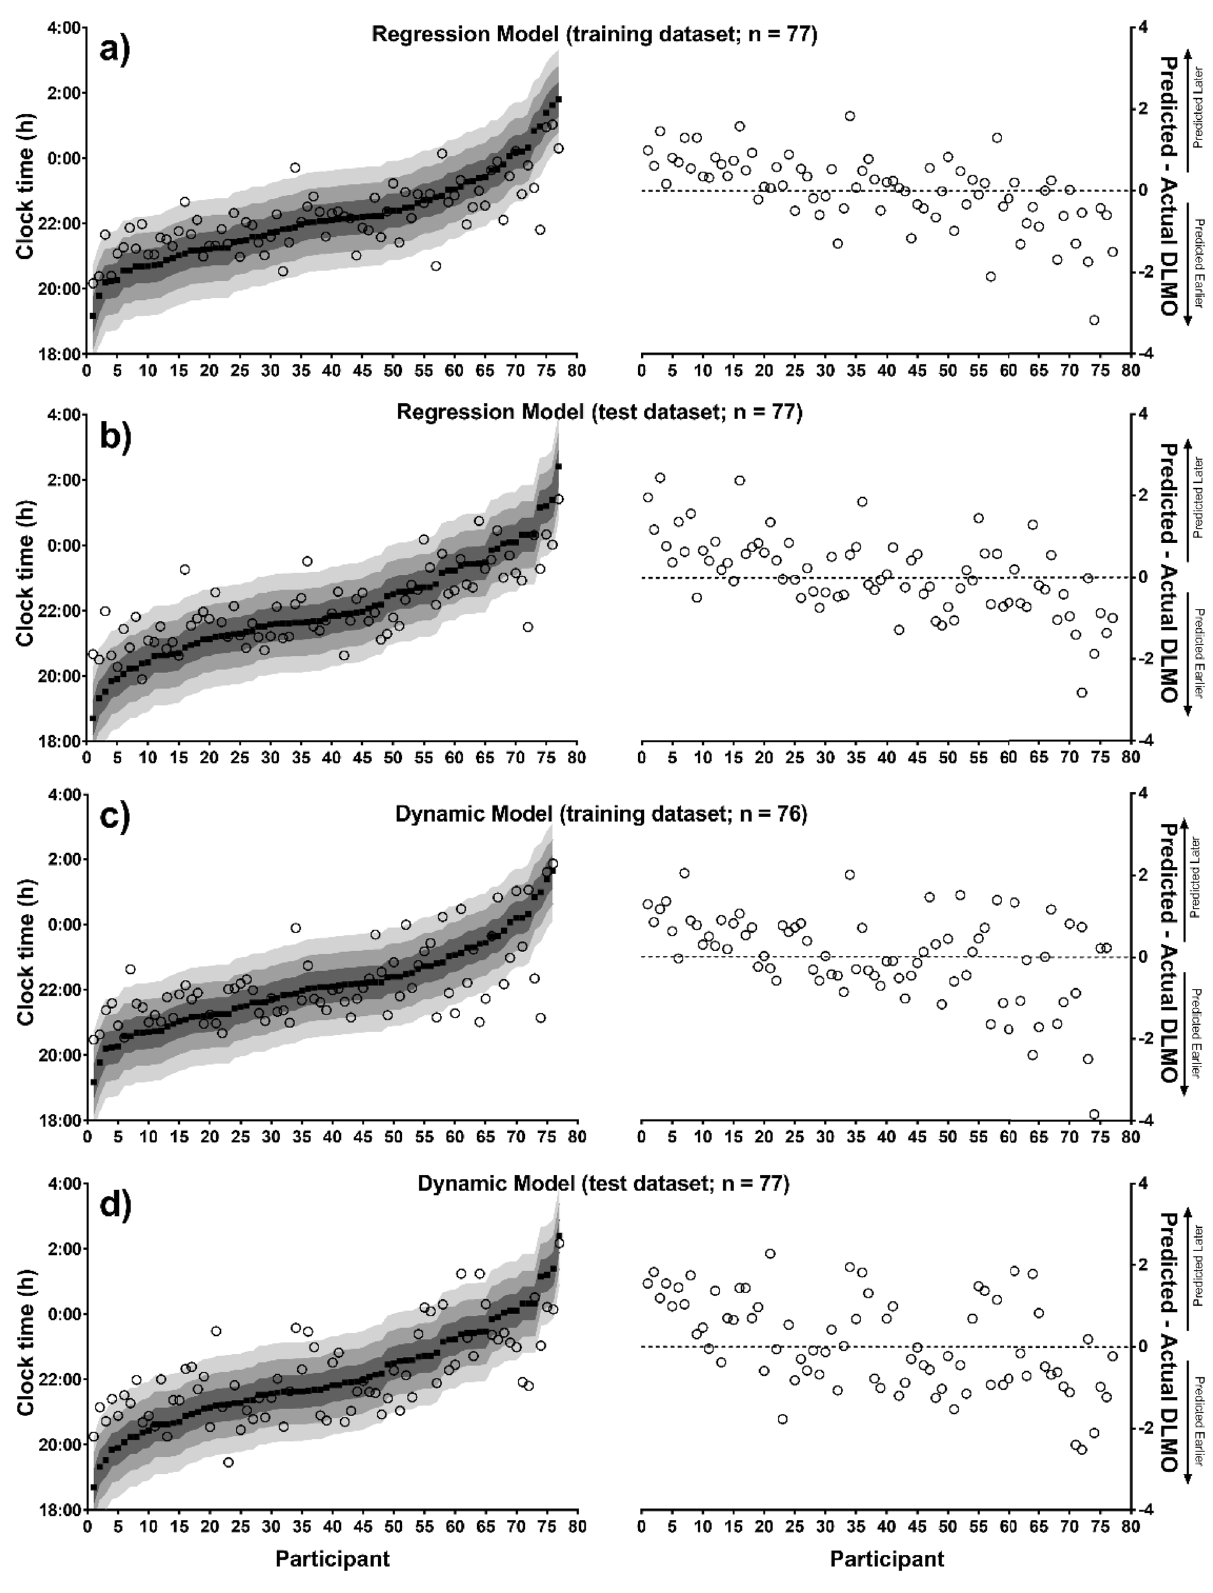
Figure 1. Distribution of actual DLMO time with corresponding predicted DLMO time. Left: Actual DLMO (black squares), ranked from earliest to latest, with corresponding predicted DLMO (open circles) and; Right: error of predictions (0 represents actual DLMO) ranked in the same order, for the statistical model training (panel a ), and test (panel b ) datasets, and the dynamic model training (panel c ) and test (panel d ) datasets. Prediction error indicated by shaded areas: = ± 30 min, = ± 1 h, = ± 1.5